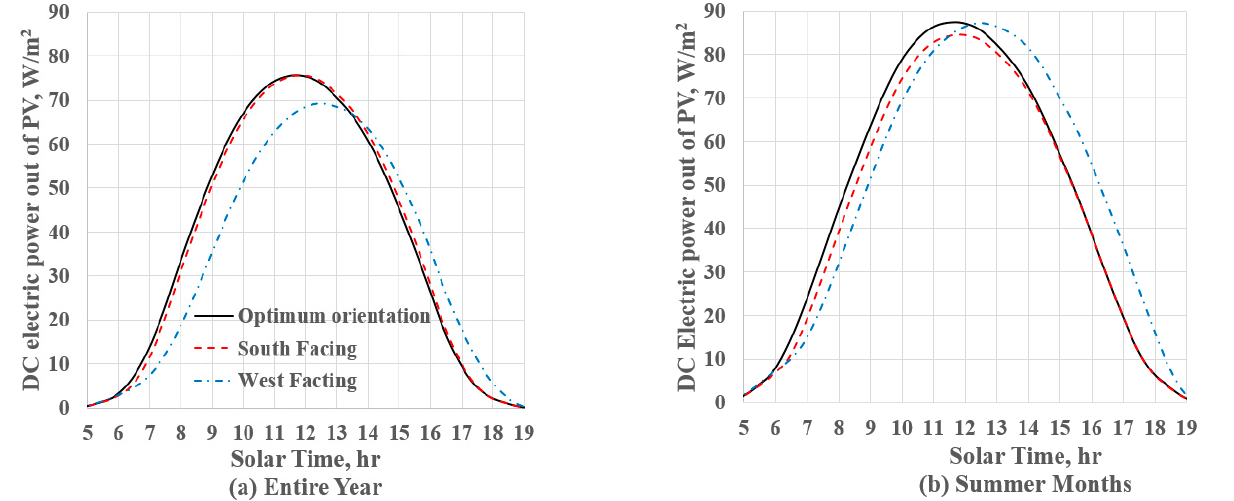
Figure 5. Average daily DC power generation for New York City, NY, USA. ( a ) For an entire year and ( b ) for summer months (June, July, and August). The average daily distribution of power for the optimum orientation and the south-facing panels generate a very similar pattern, whereas the westward-facing panel produces significantly more power during summer afternoons.